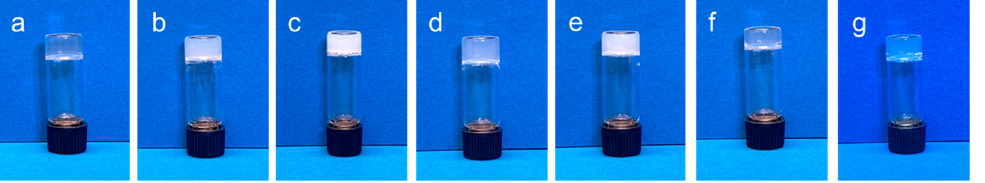
Figure 2. Photographs of hydrogels of certain AAOs at around 25 °C. ( a ) 9-2-2-6, ( b ) 11-2-2-6, ( c ) 13-2-2-6, ( d ) 13-3-2-6, ( e ) 13-4-2-6, ( f ) 13-5-2-6, and ( g ) 13-2-3-6.